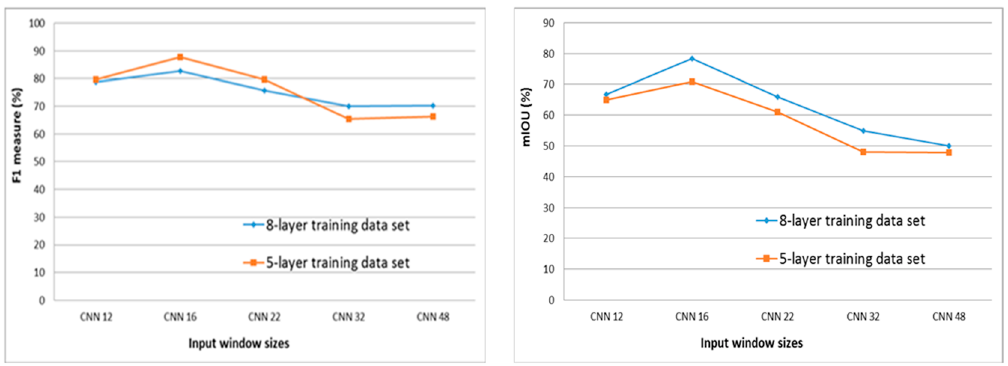
Figure 12. The influence of multiple input window sizes on the F1 measure ( left ) and mIOU ( right ) of CNN method for both 5 and 8 layer training datasets.